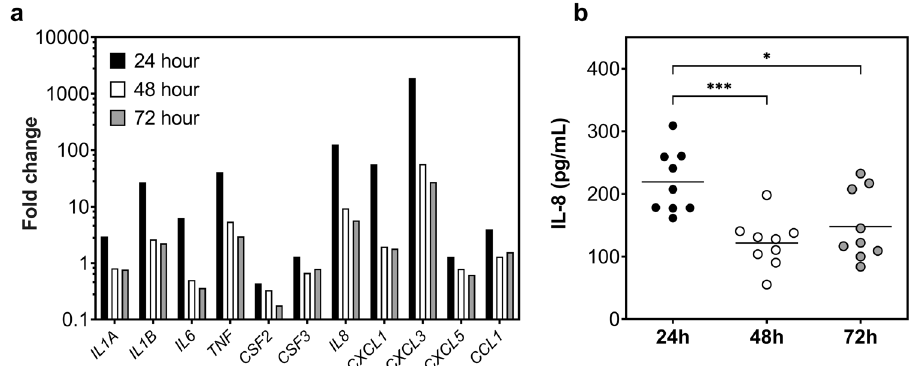
Fig. 2 In fl ammatory response in differentiated THP-1 monocytes following exposure to early and more mature bio fi lms. THP-1 monocytes (1 ×10 6 cells/mL) were differentiated using vitamin D3 then exposed to conditioned media from 24-, 48- and 72-h bio fi lms for 24 h at 37 °C, 5% CO 2 . Following incubation, RNA was extracted from the THP-1 cells, converted into cDNA then used in a qPCR pro fi ler array to assess gene expression. Data presented as fold change relative to unstimulated controls ( a ). Spent media from the co-culture was also assessed for IL-8 levels using a sandwich ELISA method ( b ). Statistical signi fi cance was determined using one-way ANOVA with Tukey ’ s post- test (* p < 0.05, *** p <